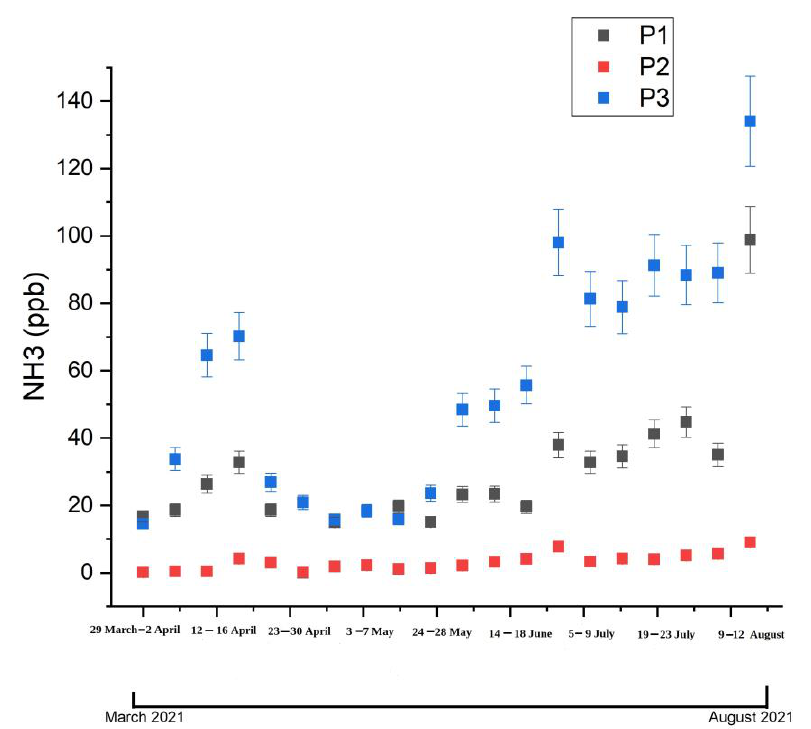
Figure 4. Average weekly ammonia concentration in the three-monitoring points P1, P2, and P3 throughout the period March – August 2021.